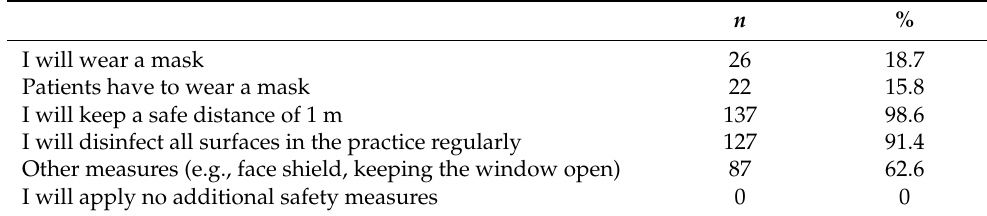
Table 6. Psychotherapists’ intended way to provide in-person psychotherapy after the end of the COVID-19 lockdown 1 .